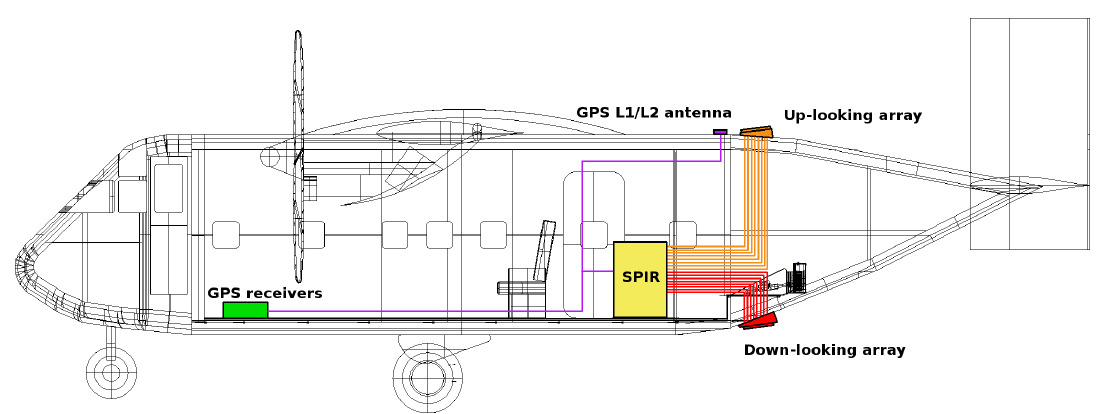
Figure 2. Location of main instrumental setup onboard Skyvan aircraft. Software passive reflectometry and interferometry system (PARIS) interferometric receiver (SPIR) is fed by 16 individual antenna elements, eight from the antenna array pointing to the zenith (orange) and eight from the antenna array pointing to the nadir (red). Ancillary GPS receivers and avionic antenna for navigation and time tagging (green and purple respectively) were also used, together with an inertial system synchronized to the GPS receivers (not depicted).